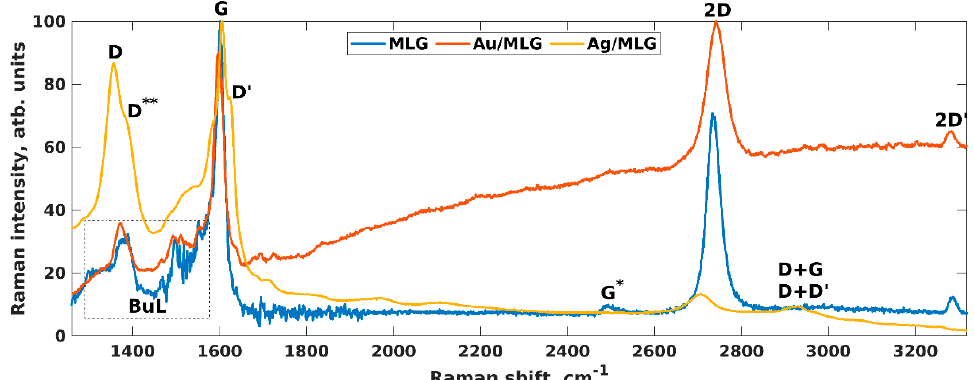
Figure 8. Typical Raman spectra of pristine epitaxial graphene, 2 nm-Au-covered epitaxial graphene, and 2 nm-Ag-covered epitaxial graphene, respectively. This figure has been adapted with permission from [49]. Copyright 2021 WILEY-VCH Verlag GmbH & Co. KGaA, Weinheim, Germany.